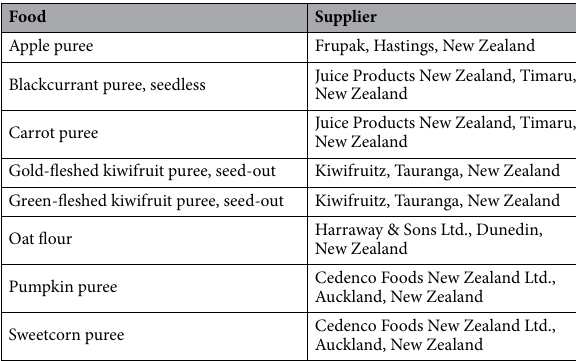
Table 1. Foods used for the in vitro gastro-intestinal digestion and